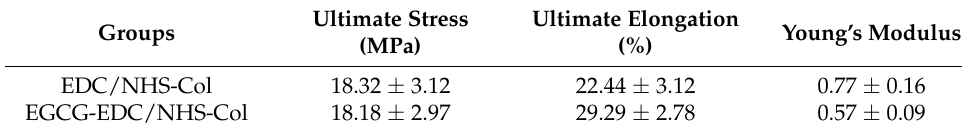
Table 2. Mechanical properties of